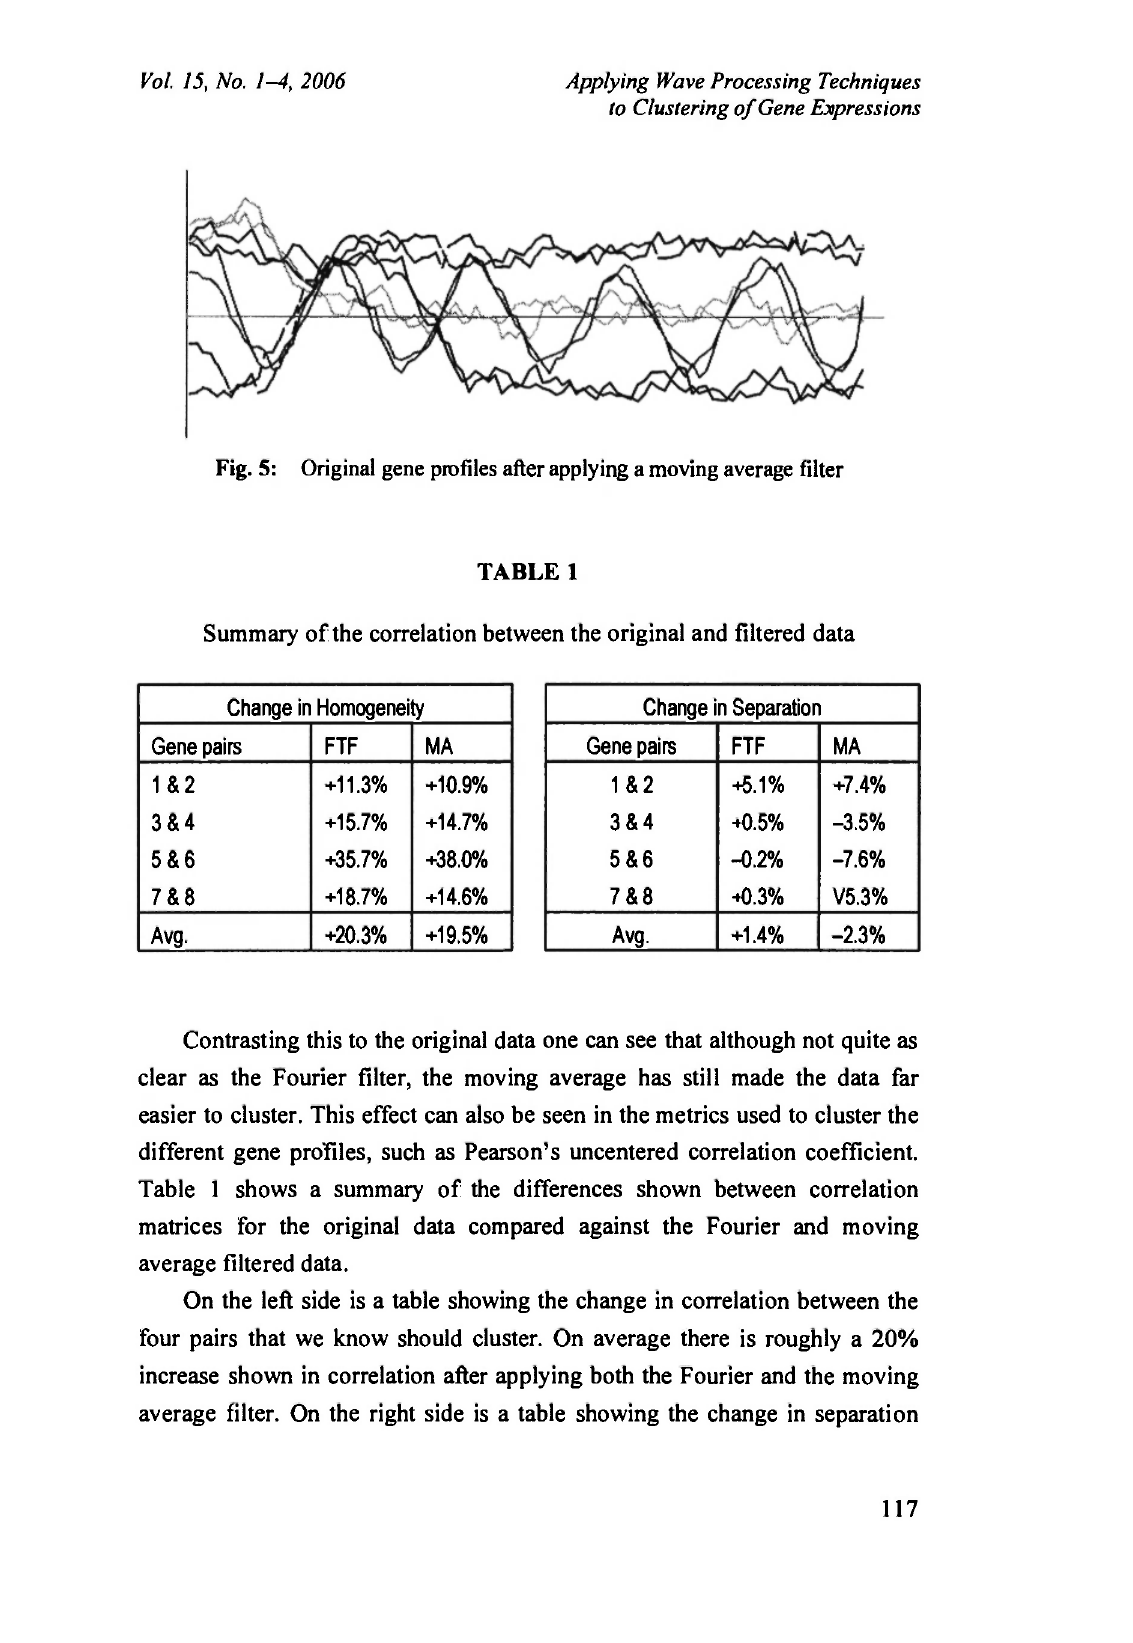
Original gene profiles after applying a moving average